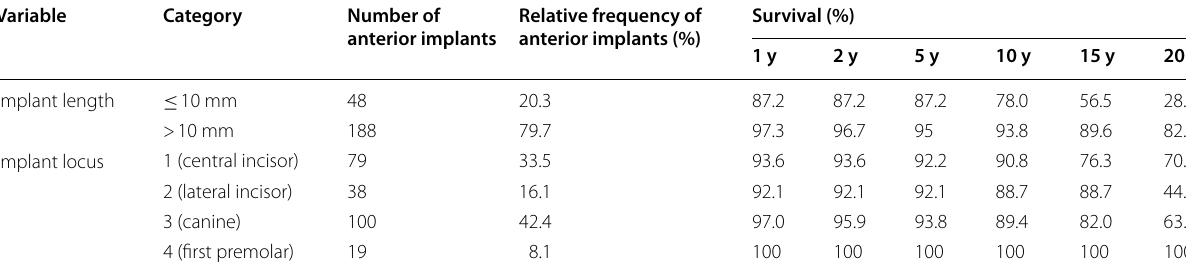
Table 6 Implant characteristics and survival